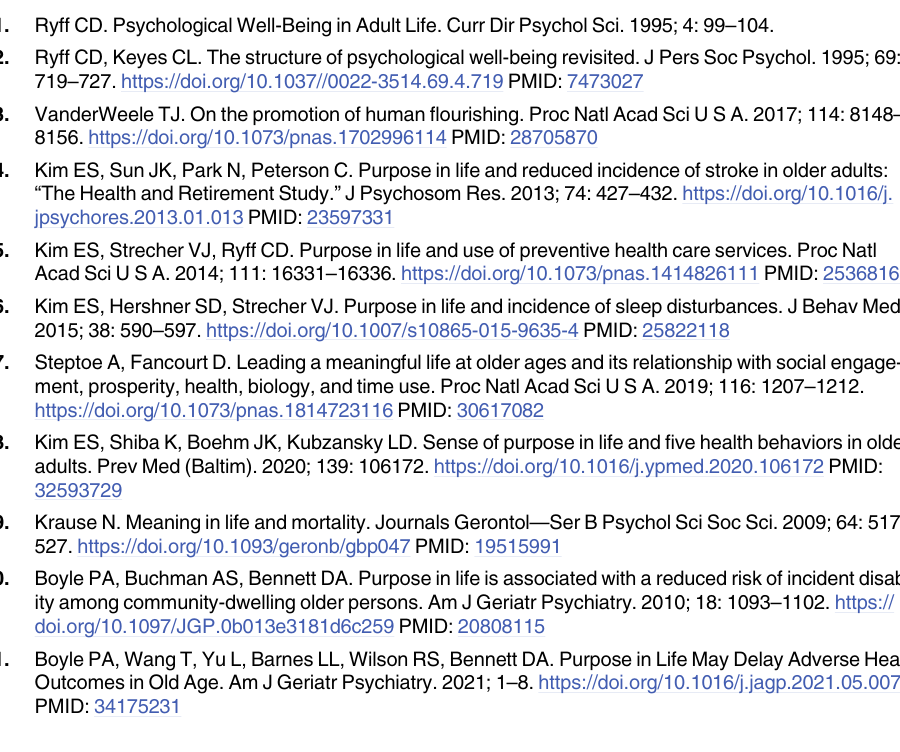
S1 Table. Standardized regression estimates for the association between baseline adher- ence to moral standards and ethical behavior and purpose in life over a four-year follow- up period in middle-aged and older adulthood (model with an interaction term). Health And Retirement Study, US, 2012/2014–2016/2018, N = 8,497 a . AMSEB = adherence to moral standards and ethical behavior; CI = confidence interval; a All missing covariate and outcome variables were imputed using the chained equations. 10 sets of imputed data were generated and the multiple imputation estimates pooled using the Rubin’s rule were